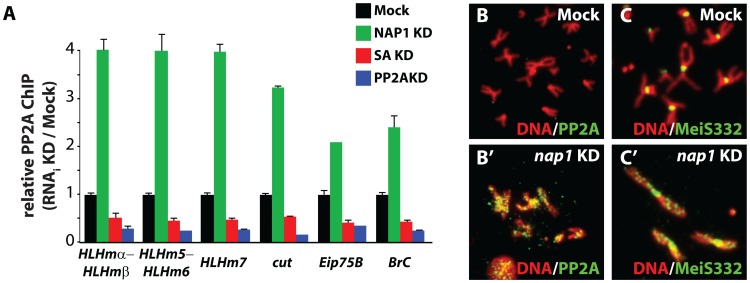
NAP1 counteracts PP2A association with chromatin.(A) ChIP-qPCR analysis of PP2A binding to the genomic loci of NAP1 and cohesin. PP2A was ChIPed from mock-treated S2 cells, or cells depleted for either NAP1 (green), SA (red) or PP2A itself (blue). ChIP signals for all knockdowns (including Mock KD) were expressed relative to the mock-treated S2 cells. ChIPs were performed using 3 biological replicates and error bars represent S.E.M. (B) Loss of NAP1 leads to PP2A accumulation on the arms of mitotic chromosomes. Indirect immunofluorescent analysis of PP2A (green) binding to mitotic chromosomes of mock-treated S2 cells (B) or after NAP1 knockdown (B′). DNA visualized by DAPI staining is shown in red. (C) Accumulation of MeiS332 on the arms of mitotic chromosomes after NAP1 knockdown. MeiS332 localizes at the centromeres of mitotic chromosomes of mock-treated S2 cells (C), but spread onto the chromosome arms after loss of NAP1 (C′).